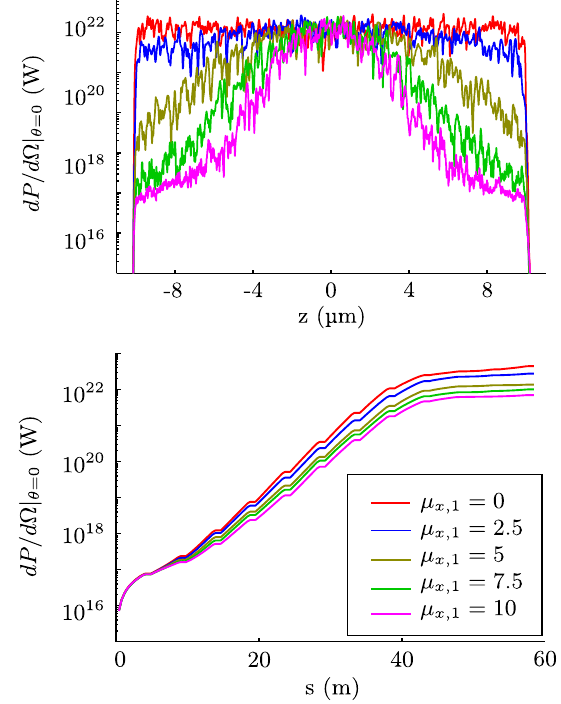
FIG. 4. Scan of μ x; 1 . The bottom graph shows the radiation growth along the SwissFEL undulator line whereas the top one represents a snapshot along the FEL pulse at the end of the undulator line.